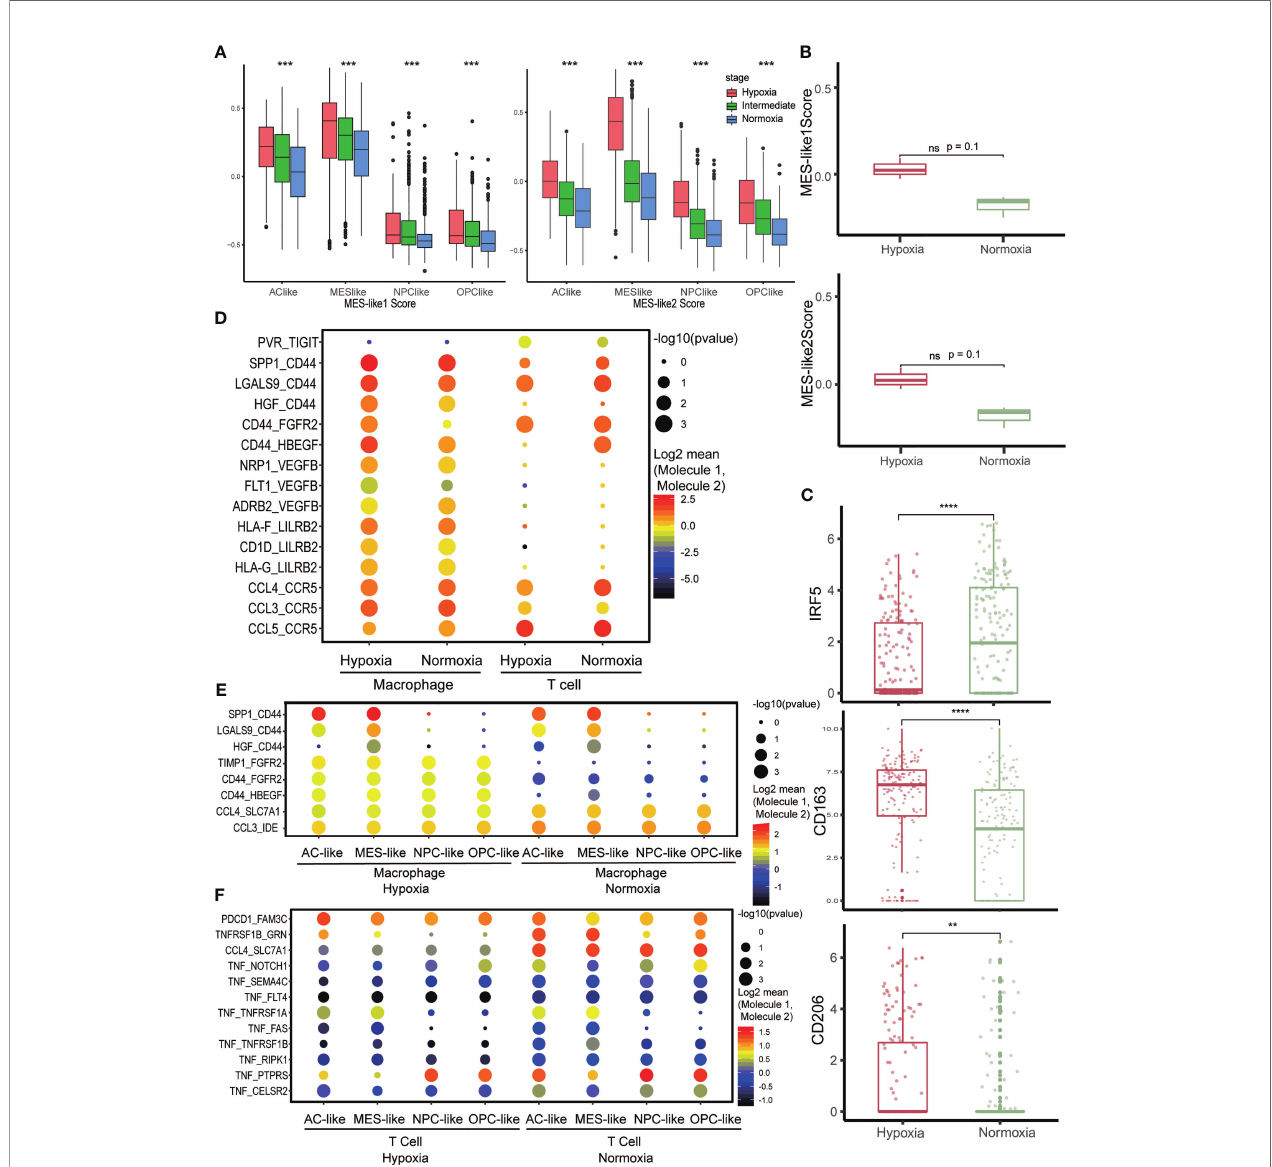
FIGURE 4 | Cell – cell communication network in the tumor microenvironment. (A) The distribution of MES-like score in each tumor cell subtype under different hypoxia status. (B) The distribution of MES-like score in primary cell lines of primary IDH-wt GBM cultured under different hypoxia conditions. Hypoxia group was cultured under 3% O 2 for 48 h, and normoxia group was cultured under 21% O 2 for 48 h. (C) The expression of macrophage marker gene in hypoxia or normoxia group. M1 marker, IRF5 and M2 markers, and CD163 and CD206 were selected. (D) Intercellular interaction within immune cells under different hypoxia conditions. (E) Cell – cell communications between macrophages and tumor cells under different hypoxia conditions. (F) Cell – cell communications between T cells and tumor cells under different hypoxia conditions. The character **, ***, **** means p < 0.01, p < 0.001 and p < 0.0001, respectively. ns, no signi fi